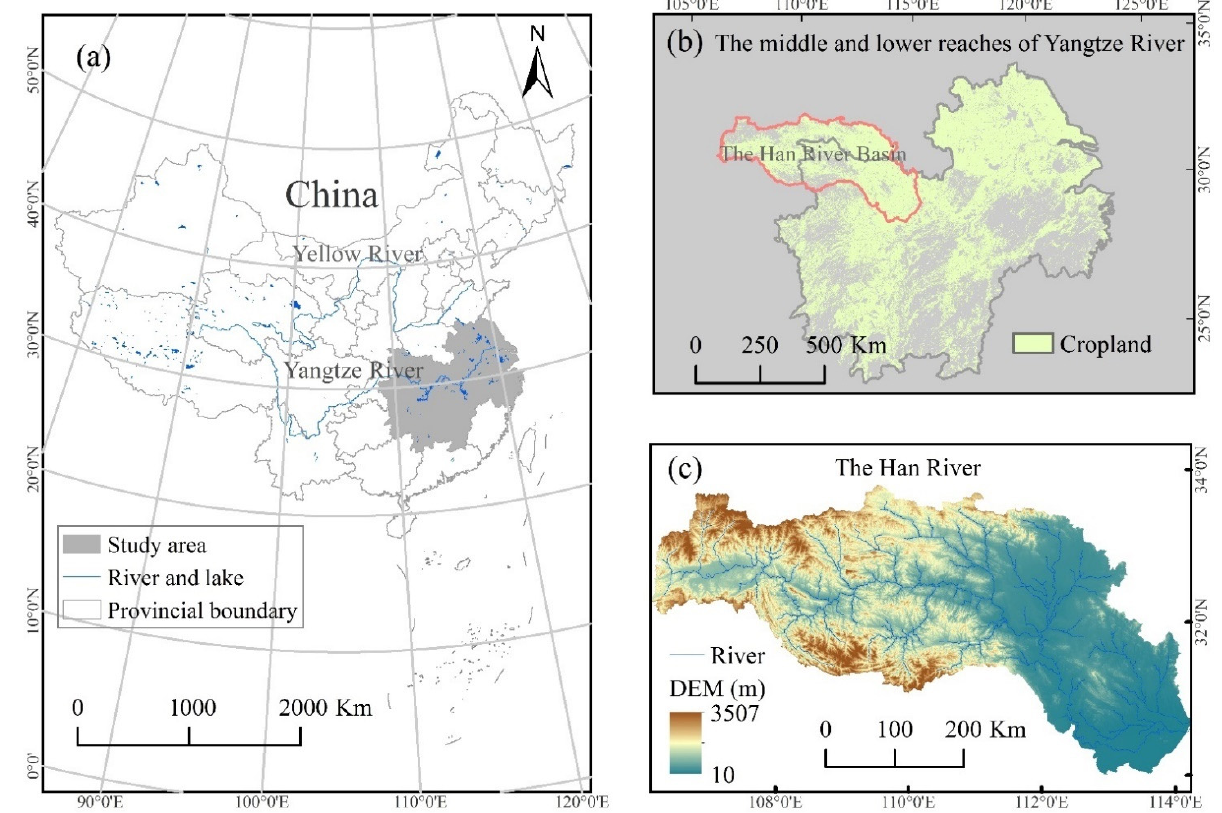
Figure 2. The study area: ( a ) China; ( b ) the middle and lower reaches of Yangtze River; ( c ) the Han River.